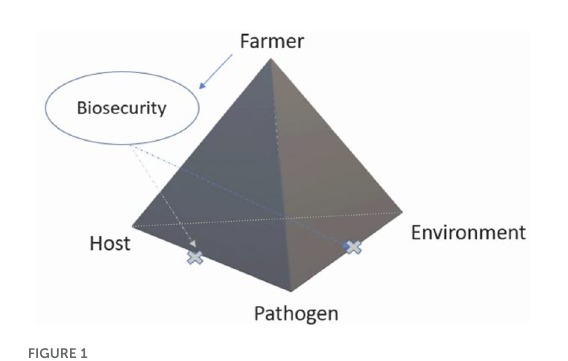
FIGURE1 The complexity of factors leading to the success of on-farm biosecurity. The influence of human activity on infectious animal diseases is pervasive; therefore, we constructed a pyramid-shaped representation in which the factors raised by farmers are specifically emphasised. Farmers play a key role in decision-making on the adopting of biosecurity measures to prevent pathogen introduction into a farm or infection of